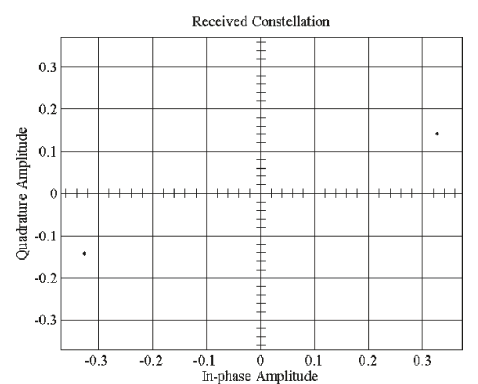
Fig. 6. End signal constellation for BPSK modulation scheme for frequency offset 2 Hz in the uplink and the downlink: with convolutional coding (rate ¾, constraint length K = 7); satellite and ground receivers noise temperatures 0 K; free space path loss 157 dB; HPAs backoff level 7 dB; phase offset is equal to zero; d 1 = d 2 = d 3 = d 4 = 1.0 m; satellite transponder phase noise is